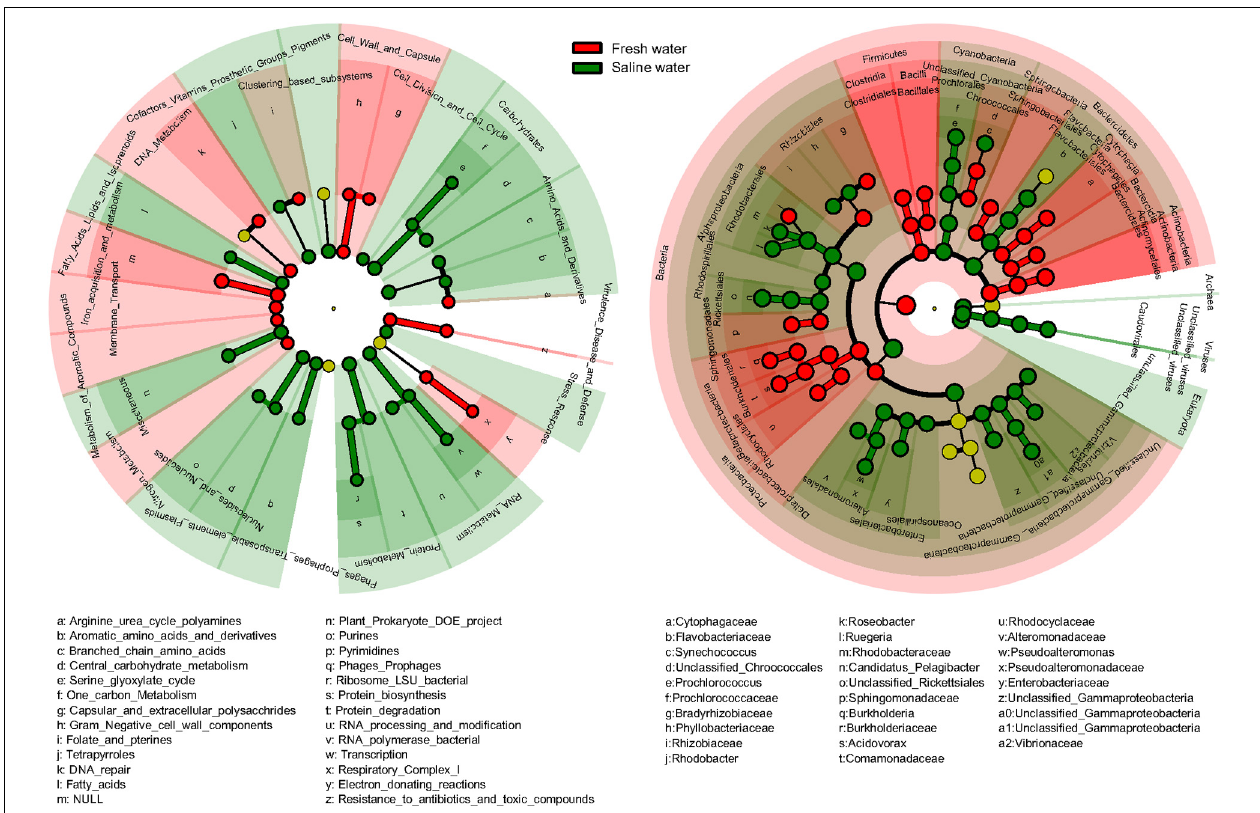
FIGURE 5 | Difference of functional and taxonomic compositions between fresh and saline water. Linear discriminant analysis effect size (LEfSe) method showing the significant differences in the relative abundance of dominant microbial functional and taxonomic compositions (mean > 1%) between fresh vs. saline water metagenomes annotated in Subsystems (Function) and RefSeq (Taxonomy). From the center outward, in the left panel, each circle represents level 1, 2, and 3 of functional annotation, and in the right panel, each circle represents the level of domain, phylum, class, order, family, and genus from taxonomic annotation, respectively. The functional and taxonomic compositions with significant differences are labeled by colors.